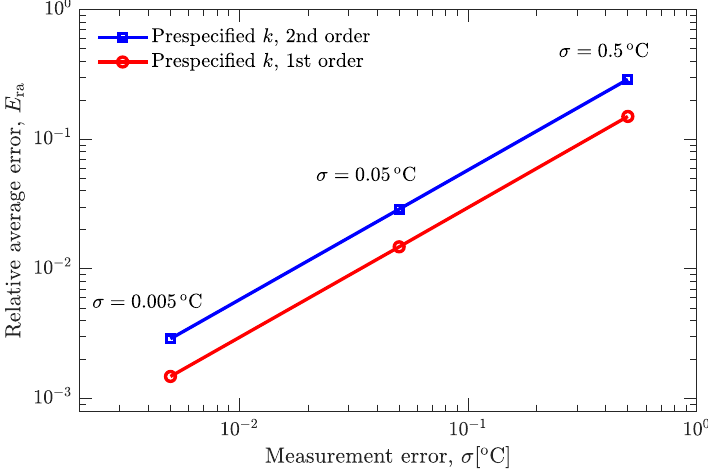
Figure 7. Effect of random noise on the relative average